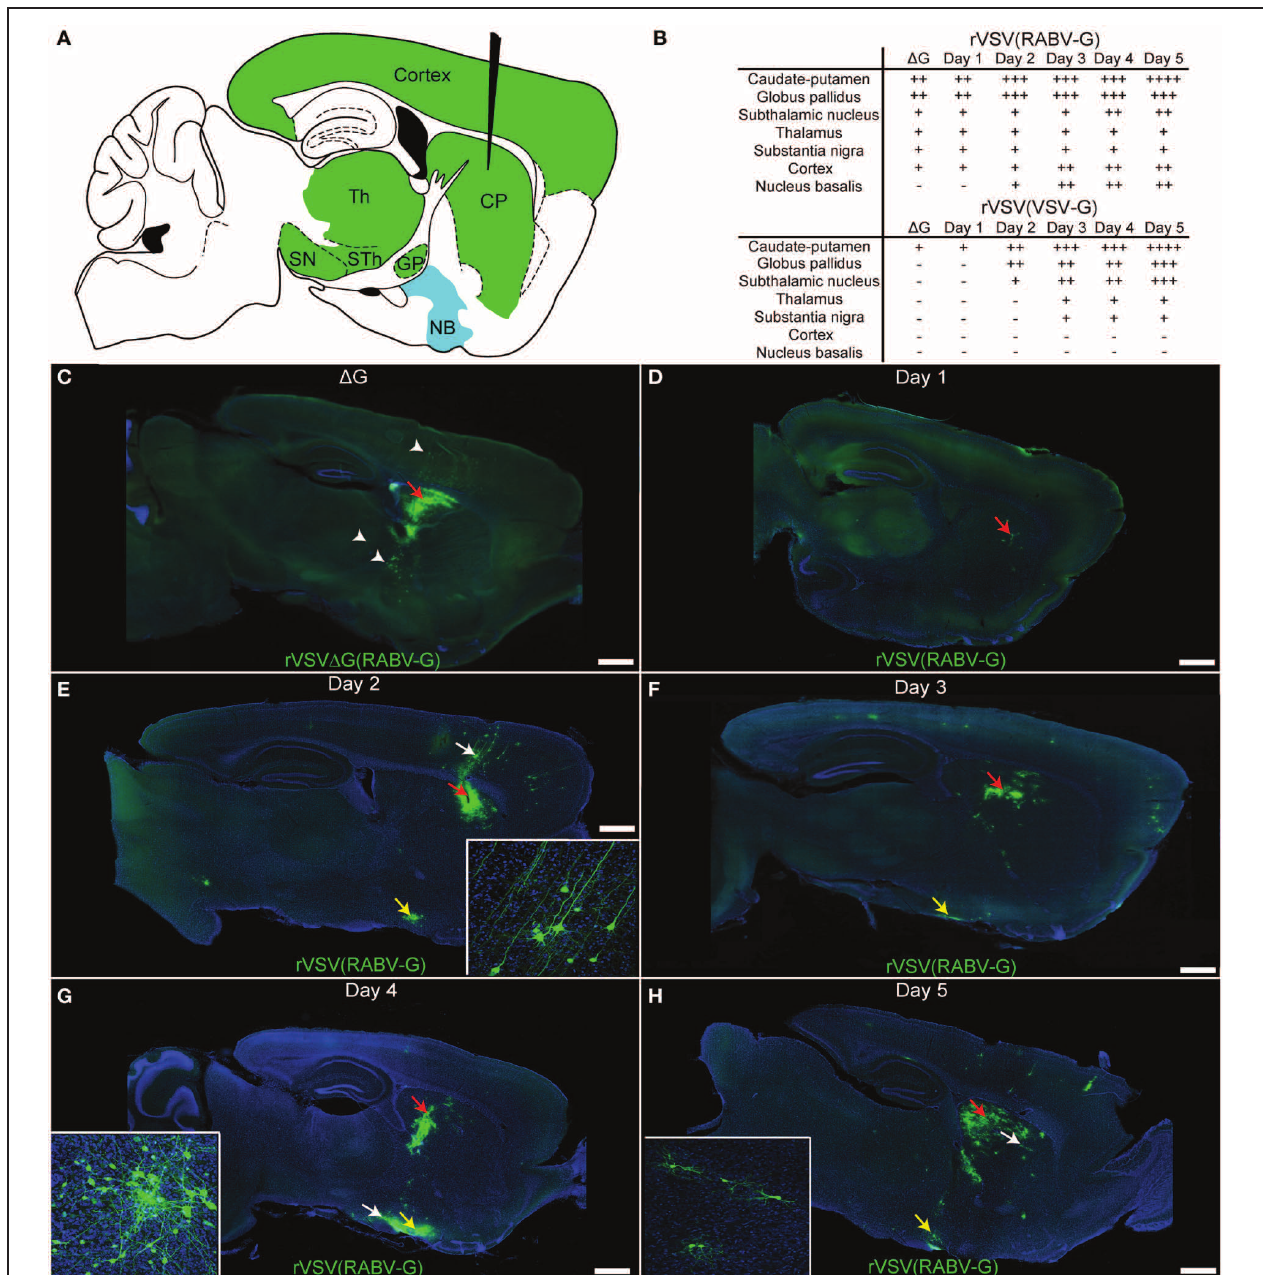
FIGURE 5 | Time course of rVSV(RABV-G) spread from the CP recapitulates the connectivity of known basal ganglia-thalamo-cortical circuits. (A) A parasaggital schematic showing the relevant projections into and from the injection site in the CP. Black needle points to injection site, green = primary projecting regions, blue = secondary projecting region. CP, caudate-putamen; GP, globus pallidus; SN, substantia nigra; STh, subthalamic nucleus; Th, thalamus; NB, nucleus basalis. (B) Assessment of viral spread from rVSV(RABV-G) and rVSV(VSV-G) injections into the CP. The presence or absence of labeling is indicated by ( + ) and ( − ), respectively. The extent of labeling is indicated by the number of ( + ). Some animals were infected with (cid:2) G viruses to determine which areas were labeled by direct uptake of the virions, rather than by replication and transmission. These were sacrificed at